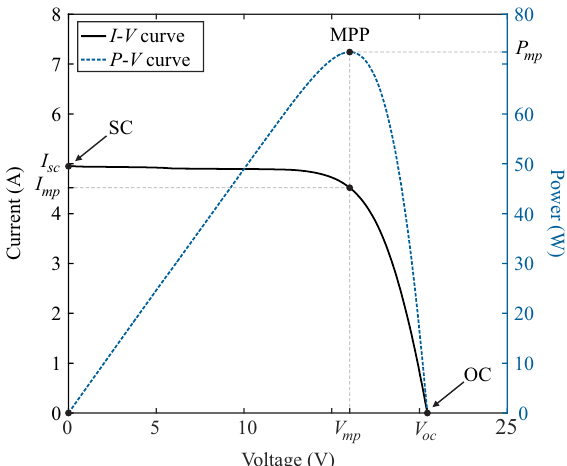
Figure 1. Characteristic curves of a single-crystalline silicon photovoltaic (PV) module operating under an effective irradiance of 985 W/m² and a temperature of 45 °C [43]. In highlight, the key- points of these curves and their respective coordinates, which is: SC = { 0, I sc } ; OC = { V oc ,0 } ; (cid:9) (cid:9) (cid:8) (cid:8) V mp , P mp V mp , I mp ; or, MPP = MPP =